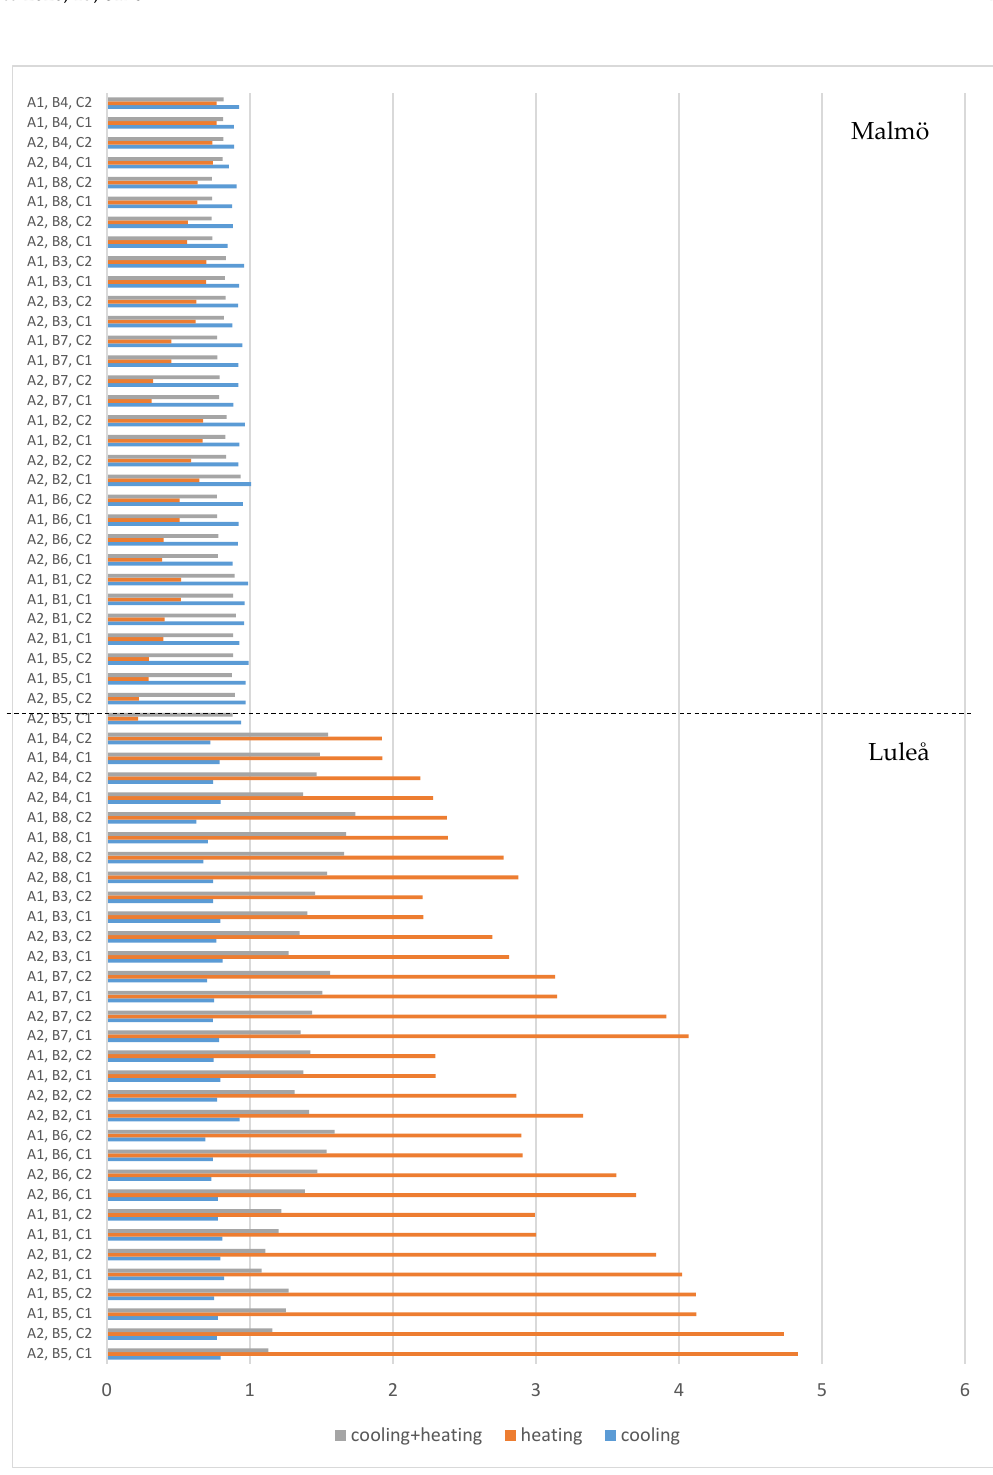
Figure 7. Cooling, heating, and total energy (cooling + heating) demand for the building located in Luleå and Malmö compared to the building located in Linköping. Internal gains B1–B8 is ordered from lowest to highest. A1 is angled façade and A2 is straight façade. C1 is without blinds and C2 is with blinds.